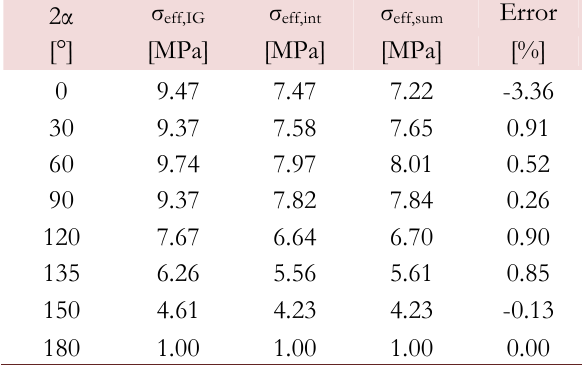
Table 2: Value of σ eff,IG , σ eff,int and σ eff,sum at any tested angle.